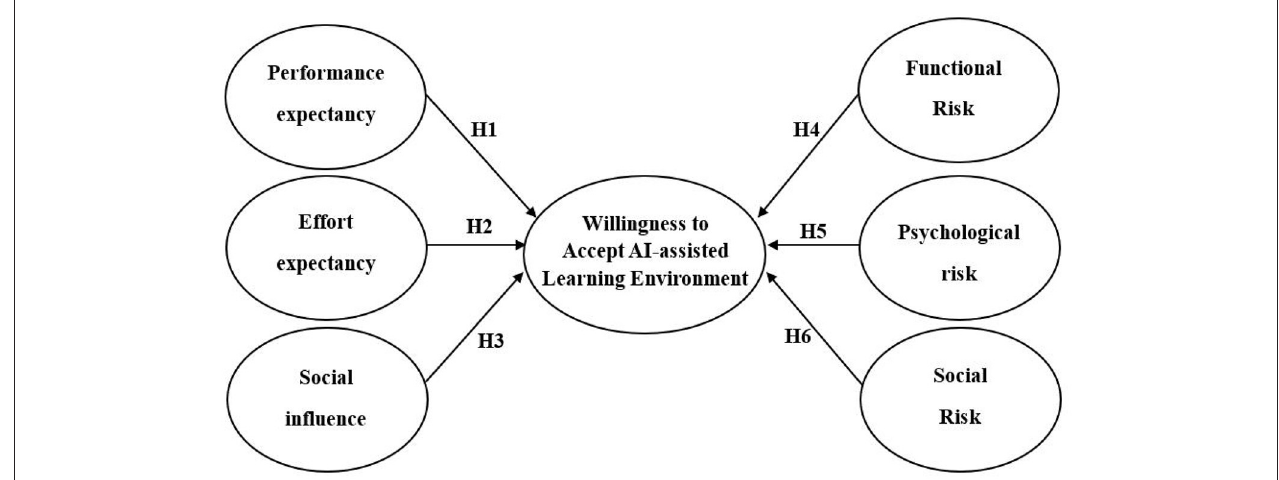
FIGURE 1 | Research